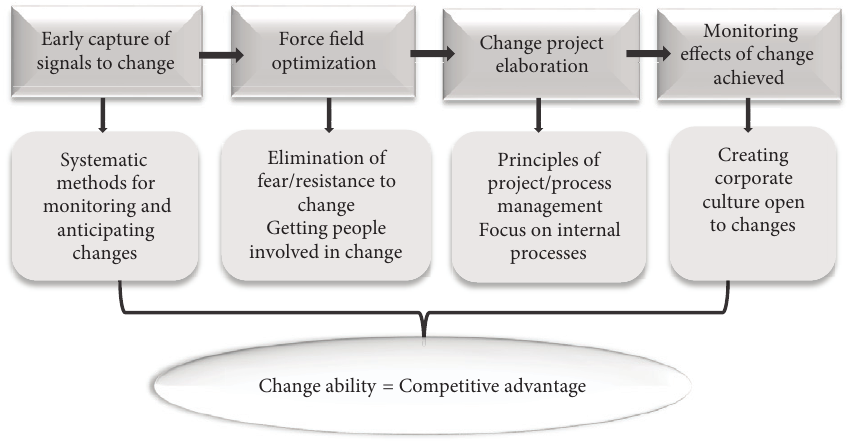
Figure 8. The conditions of an effective change management (source: own processing) The key success factor by management of operative optimizing and emergent changes, the fast preparation of change is. The project of change must be simple, clear, and enforceable so that implementation of changes will be successful. An effective and recommended